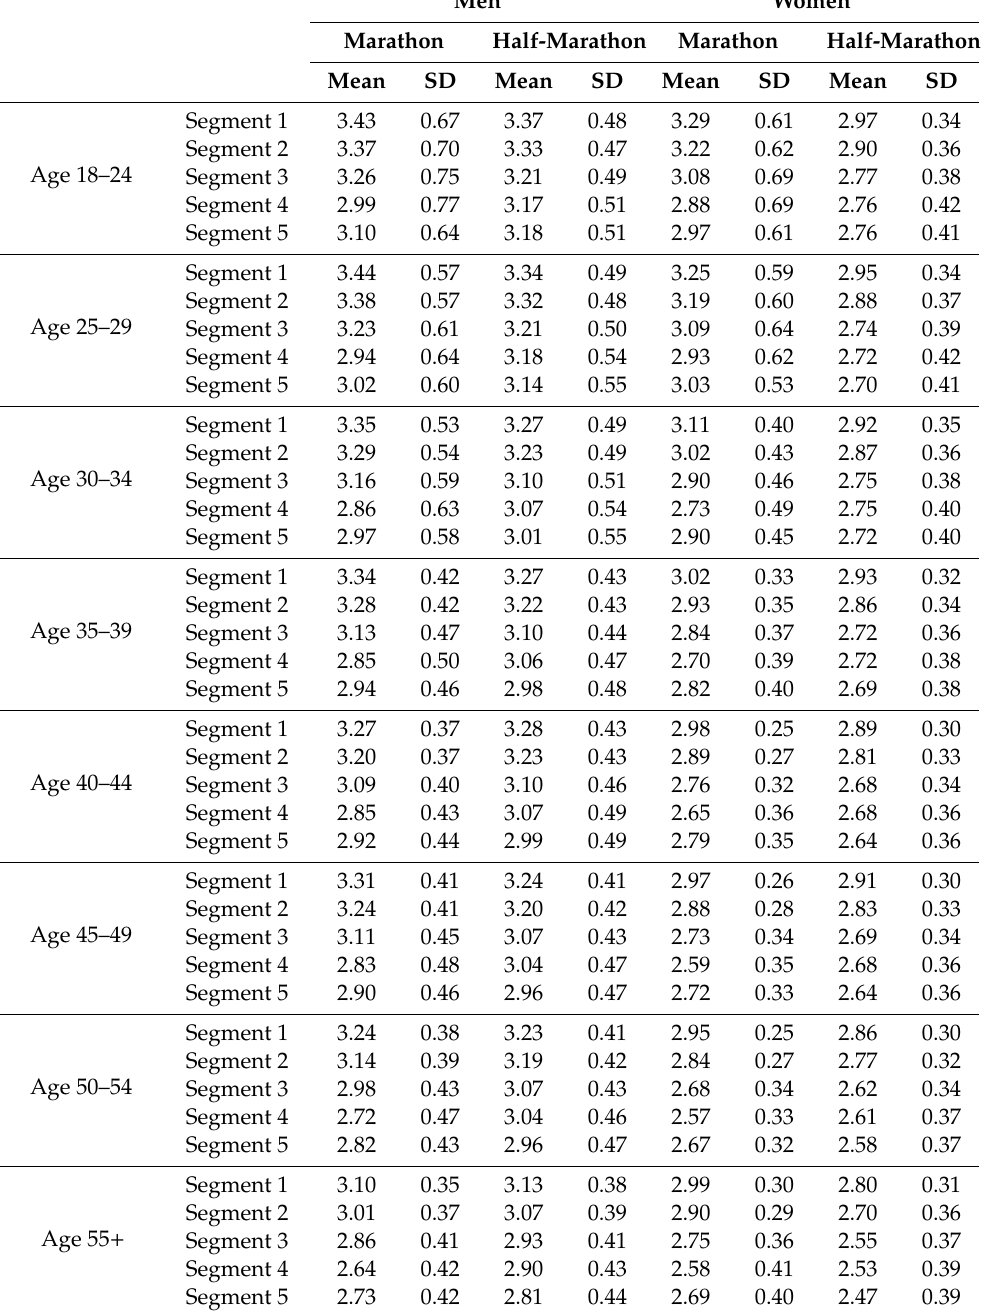
Table 2. Segments and race speed for men and women, marathon and half marathon runners for each age